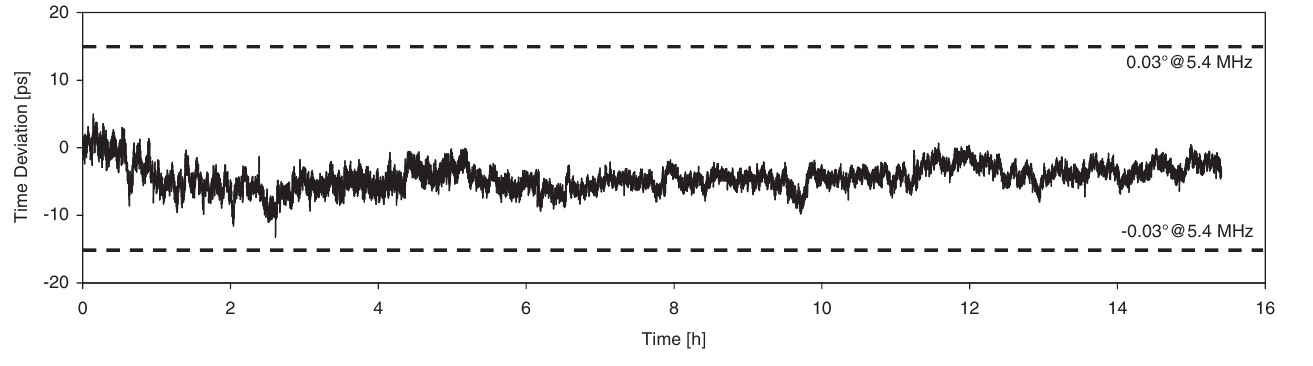
FIG. 15. Time deviation of the reference signals at two different end points of the system (average interval 1 s).